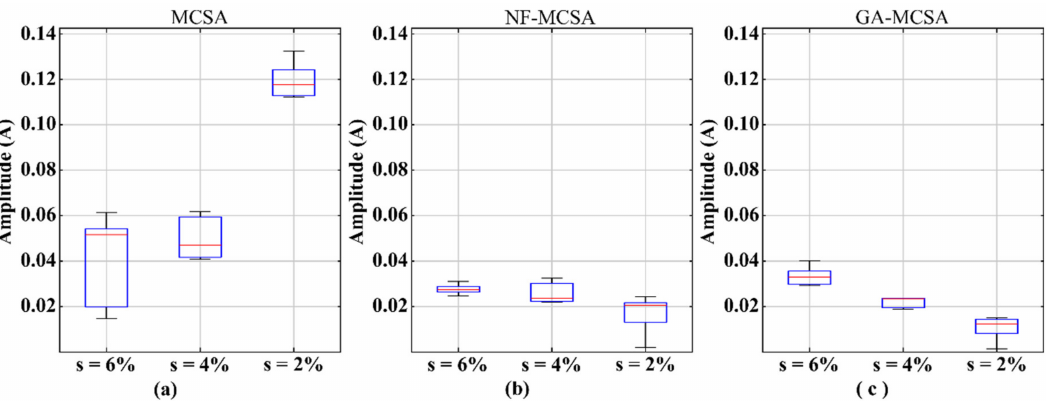
Figure 6. Boxplots for the amplitude results of the LSH at 20 Hz for the ( a ) common MCSA technique, ( b ) NF-MCSA technique, and ( c ) GA-MCSA technique.